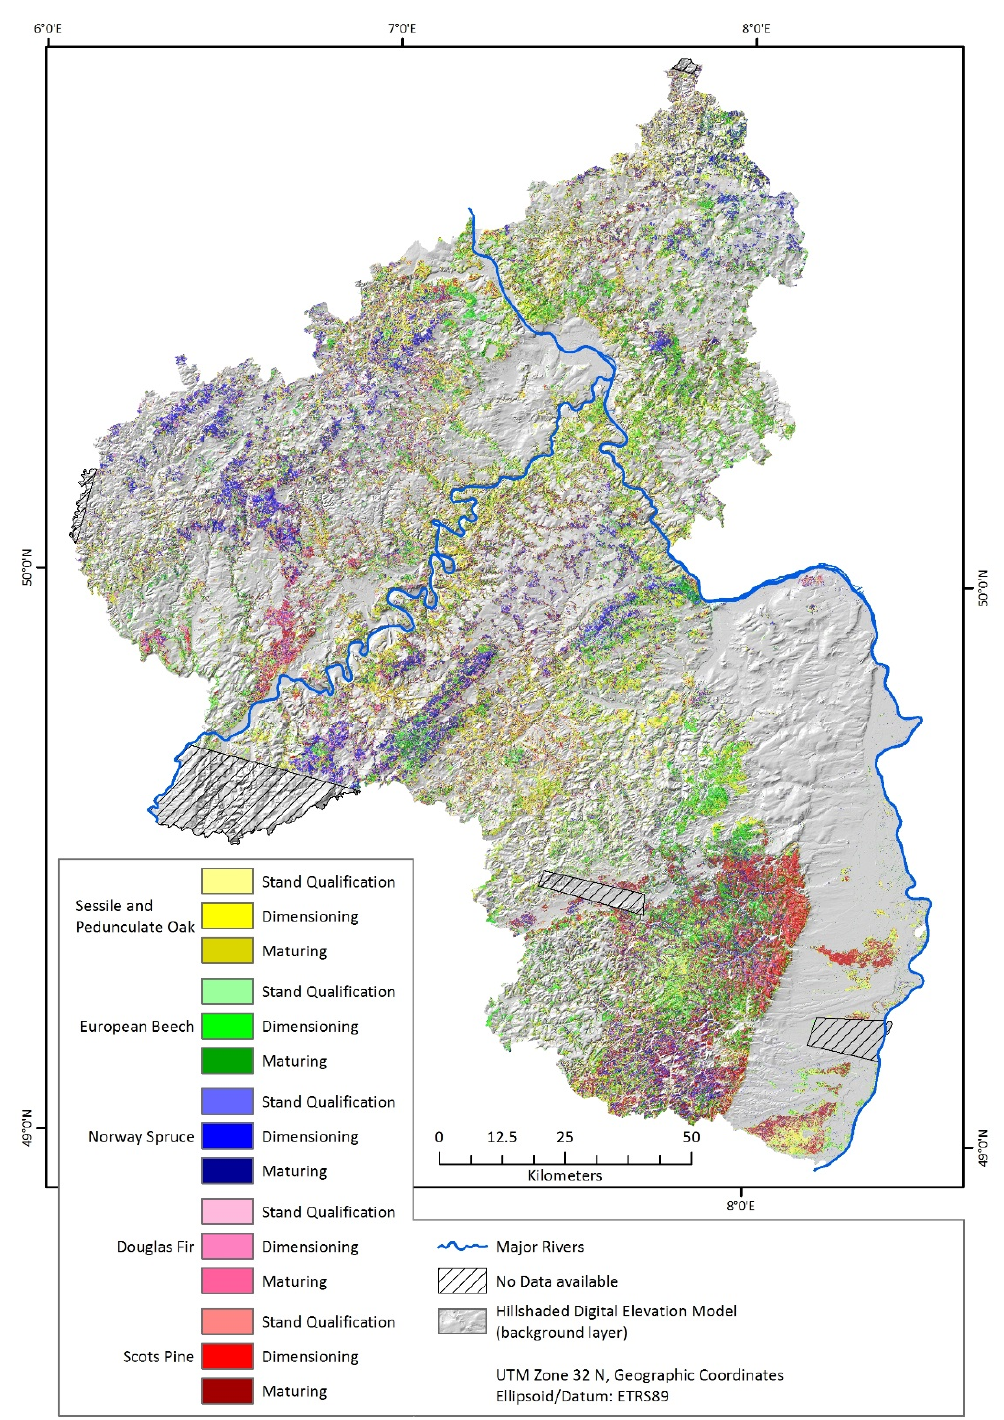
Figure 6. Map of tree species distribution and development stages throughout